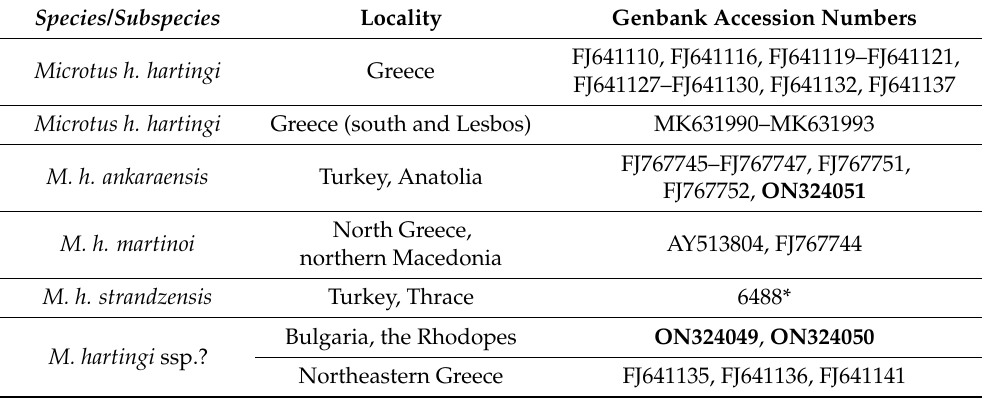
Table 1. The materials subjected to the analysis of Cytb variation. Sequences obtained in the current study are boldfaced. The sequence (6488*) of M. hartingi strandzensis from Turkish Thrace was provided by the authors of ref.